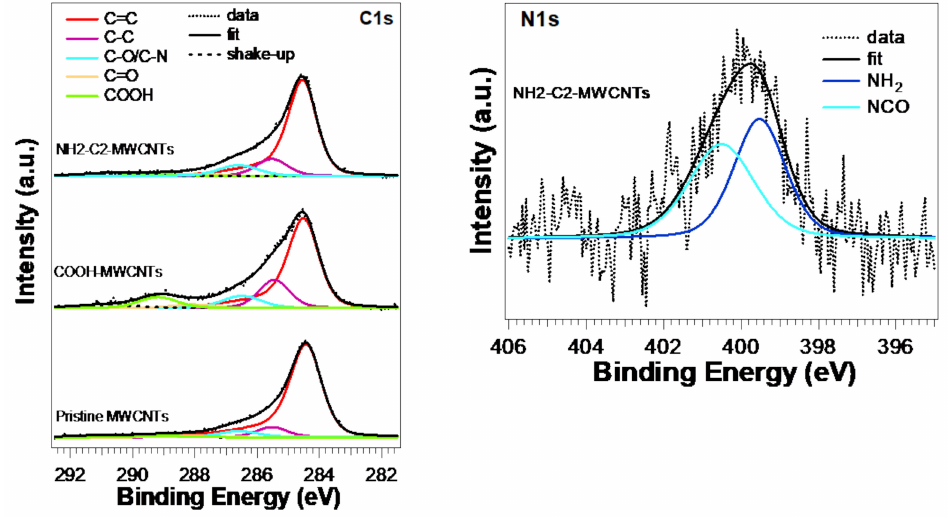
Figure 4. XPS core-level spectra and lineshape analysis of C1s ( left ) and N1s ( right ) of pristine MWCNTs, COOH − MWCNTs, and NH 2 − C 2 − MWCNTs.